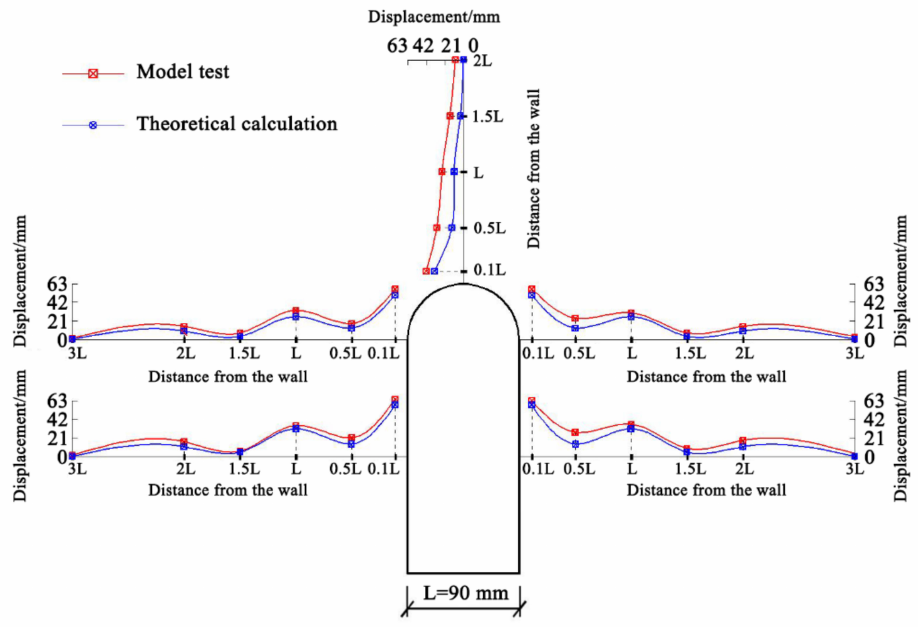
Figure 10. Variation of the radial displacement around the cavern. Table 3. Radial displacement around the